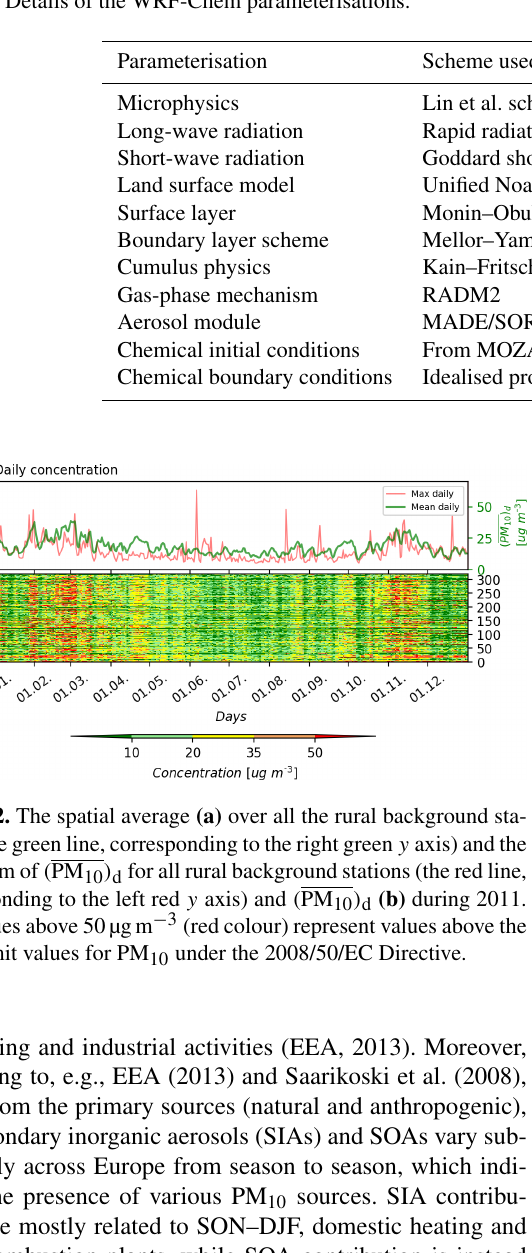
Table 2. Details of the WRF-Chem parameterisations.